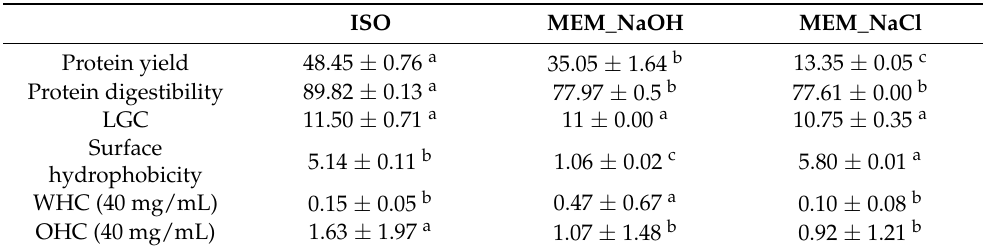
Table 5. Yield, digestibility, least gelation concentration (LGC), surface hydrophobicity, water hold- ing capacity (WHC, pH 7.0), and oil holding capacity (OHC) of isoelectric precipitated protein isolate (ISO), and membrane protein isolates from alkaline (MEM_NaOH) and salt (MEM_NaCl) solution